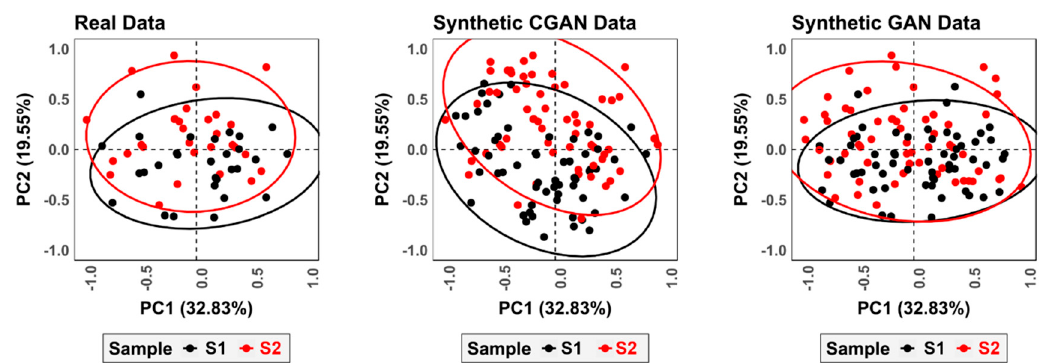
Figure 9. PCA scatter plot presenting data augmentation techniques on DS3. Ellipses mark 95% confidence intervals. Both CGAN and GAN were trained using Wasserstein Gradient Penalty loss.